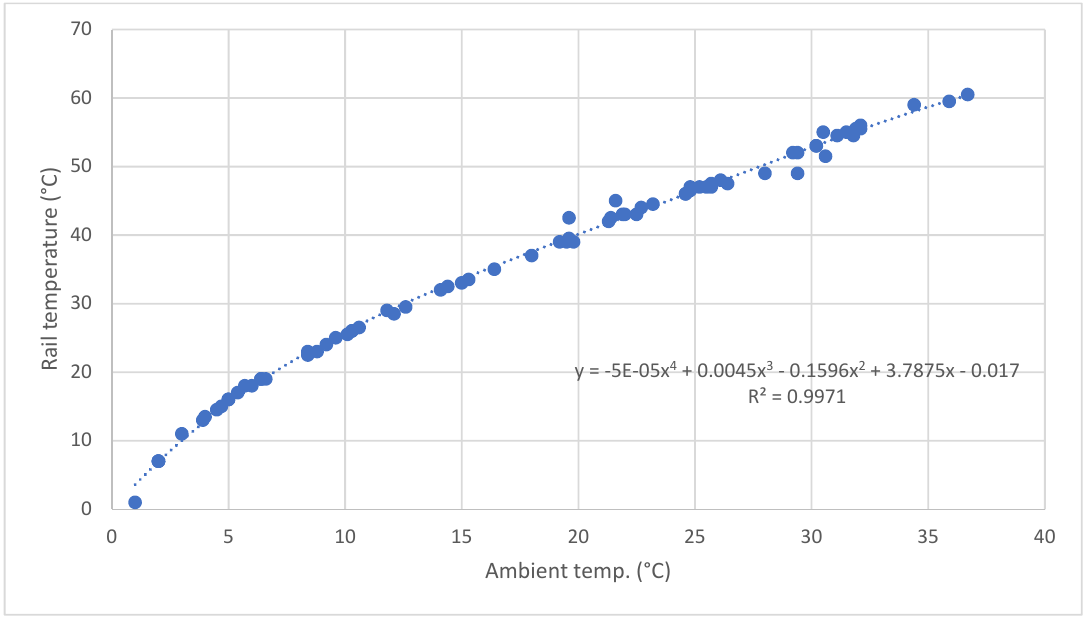
A graph of the dependence of rail temperature under load on ambient temperature is shown at Figure 16.